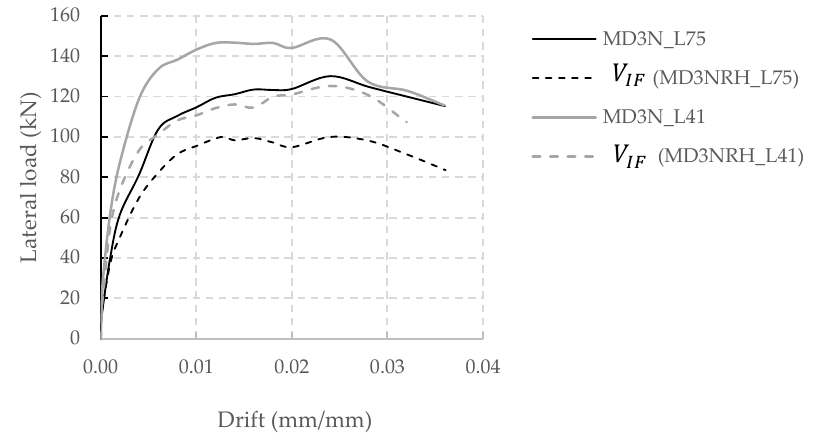
Figure 13. Contribution of infilled frame.